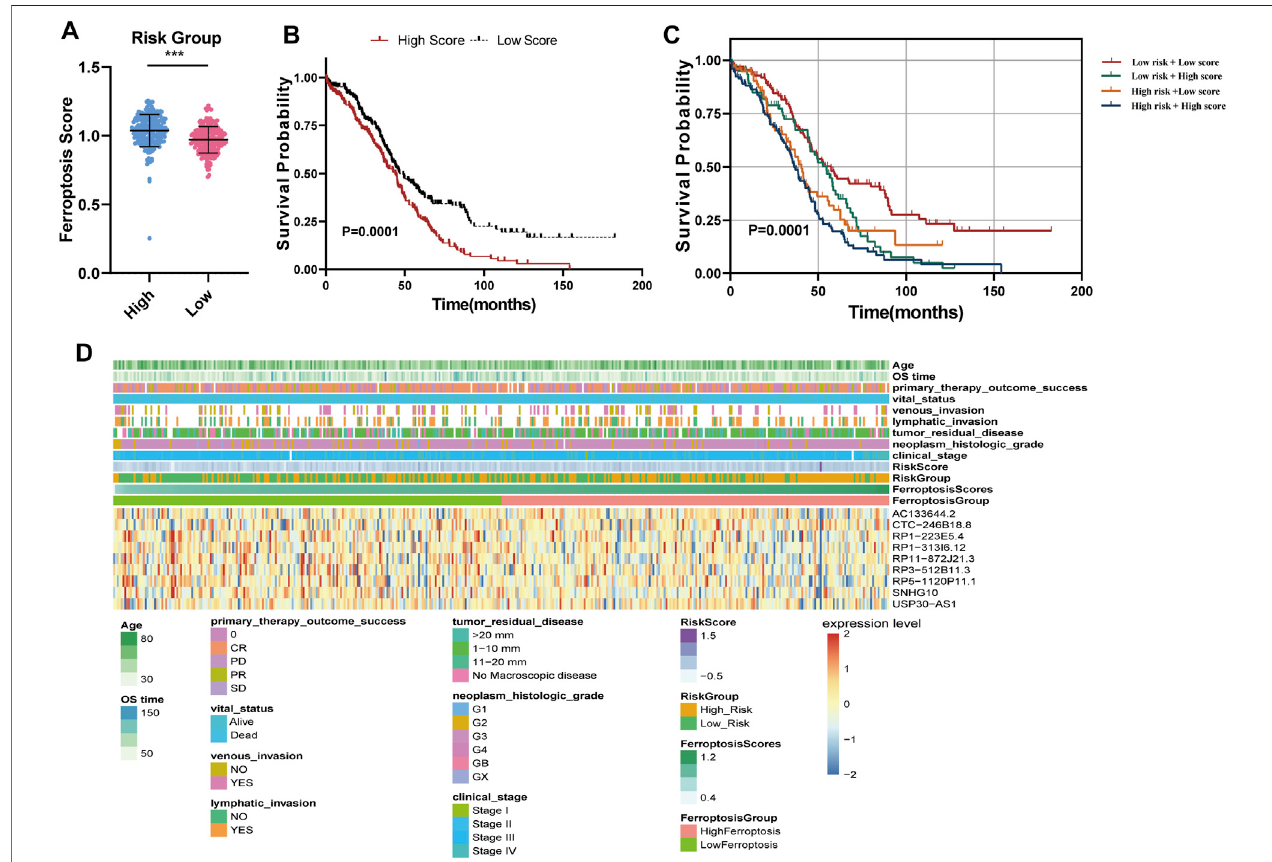
FIGURE 5 | Ferroptosis score analysis (A) Ferroptosis scores between high and low-risk groups (B) The K – M survival curves of OC patients with high or low ferroptosisscore (C) TheK – Msurvivalcurvesoffoursubgroupsbasedonriskscoreandferroptosisscore (D) Heatmap oftheassociationsamongtheexpressionlevels of nine FRLs, risk scores, ferroptosis scores and clinical